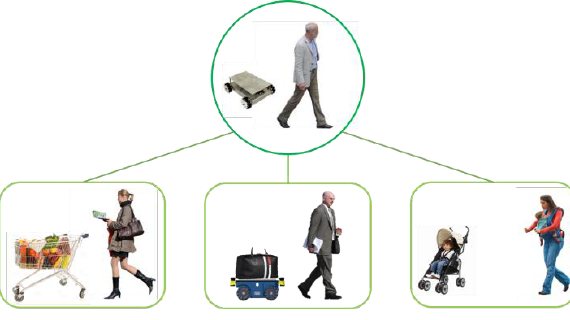
Figure 1 . Application of the Pet-Bot system. Figure 1. Application of the Pet-Bot